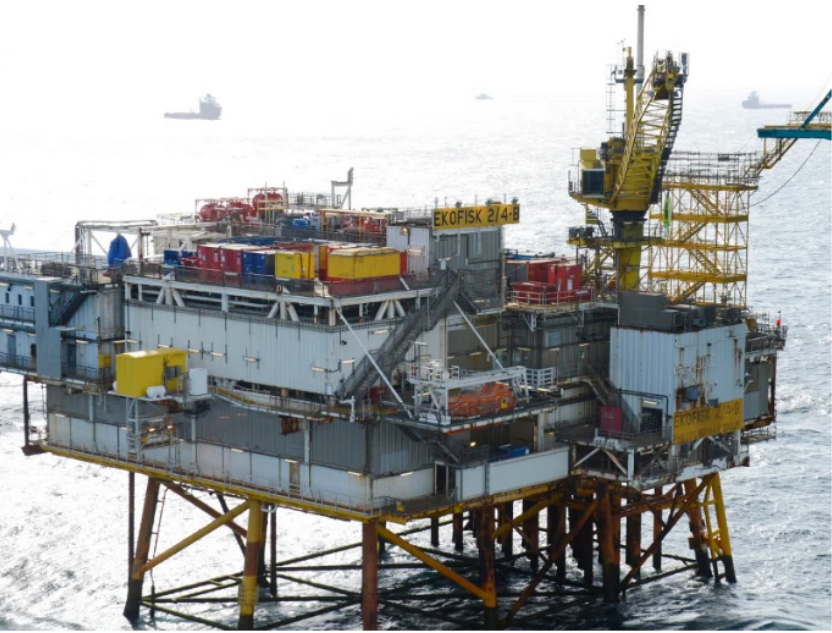
Figure 9. Ekofisk 2/4 B platform is the longest-standing fixed offshore platform in the world, which lies in the North Sea and operated by ConocoPhillips. (Permission to use image was obtained from Dennis Nuss of ConocoPhillips. Photo Credit: ConocoPhillips). Table 2. Sustainable maintenance management found on offshore structures that are among the longest standing fixed offshore platforms.